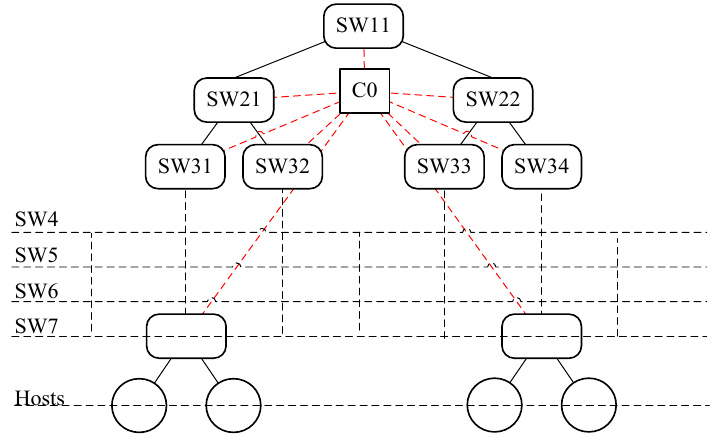
Figure 9. Network Scenario 2: Tree,7,2.